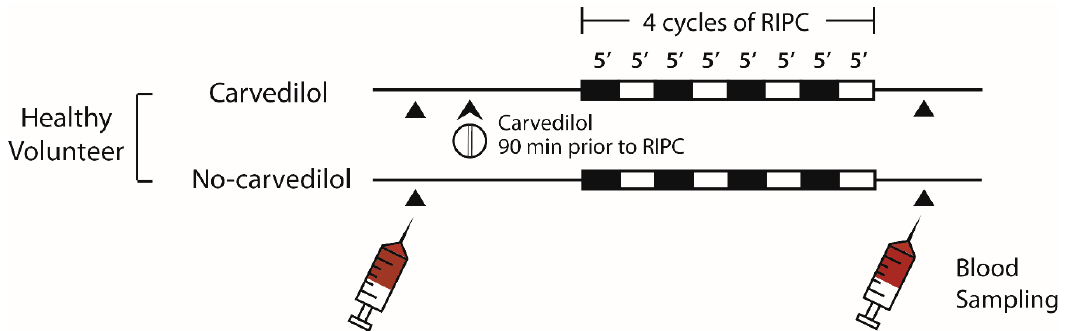
Figure 6. Schematic diagram of the study protocol of healthy volunteers. RIPC, remote ischemic preconditioning.